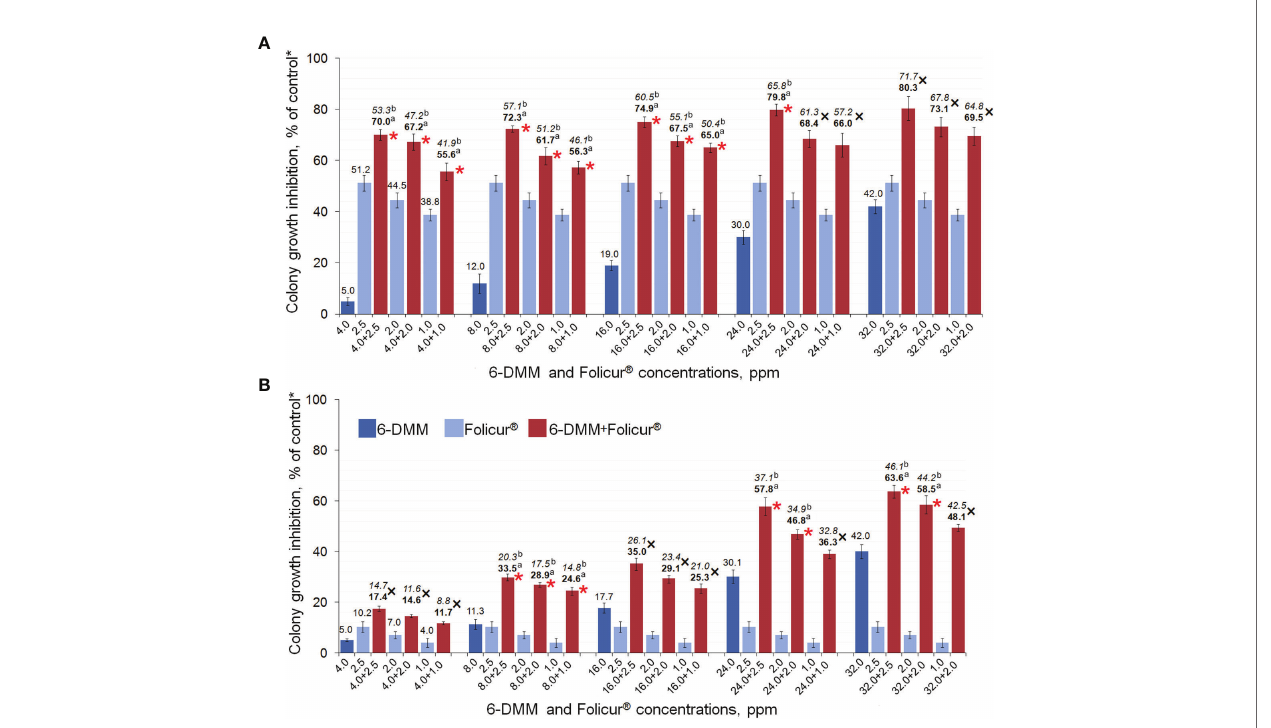
FIGURE 5 | The enhanced inhibitory effect of 6-DMM combined with Folicur ® EC 250 on in vitro growth of wild M-4 (A) and resistant m8-4 (B) strains of P. nodorum . *Control colonies were cultured on potato dextrose agar free of 6-DMM and fungicide. Each histogram column represents the mean of three experiments. Y-bars indicate SD. The numbers in bold or regular above the columns indicate Er values, while italic numbers show Ee values related to the same fungicide-6-DMM concentration combination. Er indicates inhibition (%) of the colony growth when fungicide and 6-DMM were co-applied; Ee is the estimated inhibition (%) of colony growth if there is an additive effect of fungicide and 6-DMM. Where Er > Ee at p ≤ 0.05, a synergistic interaction between fungicide and sensitizer is con fi rmed. The 6-DMM-Folicur ® combinations resulting in a synergistic effect (Er > Ee at p ≤ 0.05) towards M-4 (A) and m8-4 (B) are designated with red asterisks placed near columns. Different letters (a, b) indicate signi fi cant difference between Er and Ee (95% CI). In fi ve (A) and eight (B) other cases marked with a black “ × ” , 6-DMM- Folicur ® interactions were additive (Er > Ee at p > 0.05). Ee values are calculated by the formula Ee = (X + Y) – XY/100 (Richer, 1987), where X and Y represent percent growth inhibition by each of the components